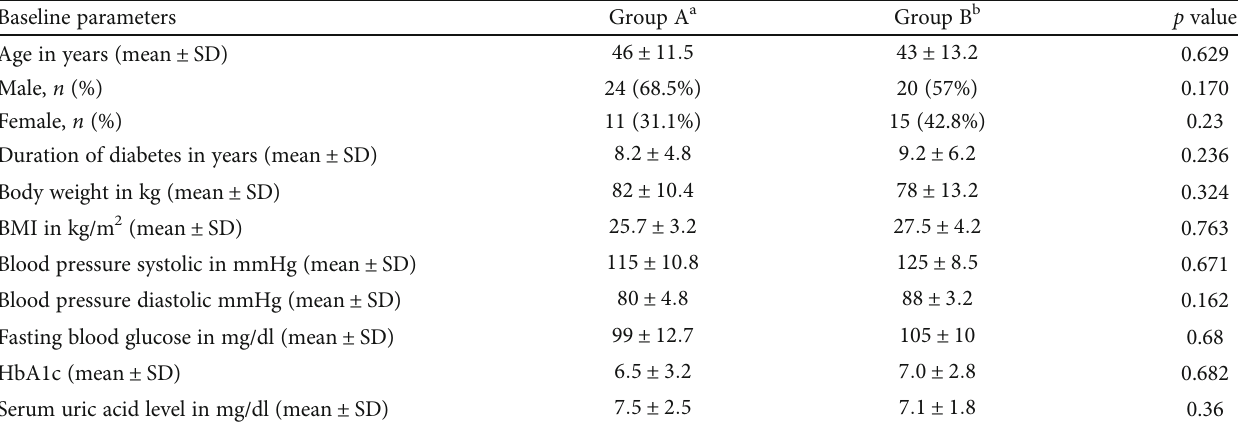
Table 1: Baseline demographics characteristics ( N = 70 ).